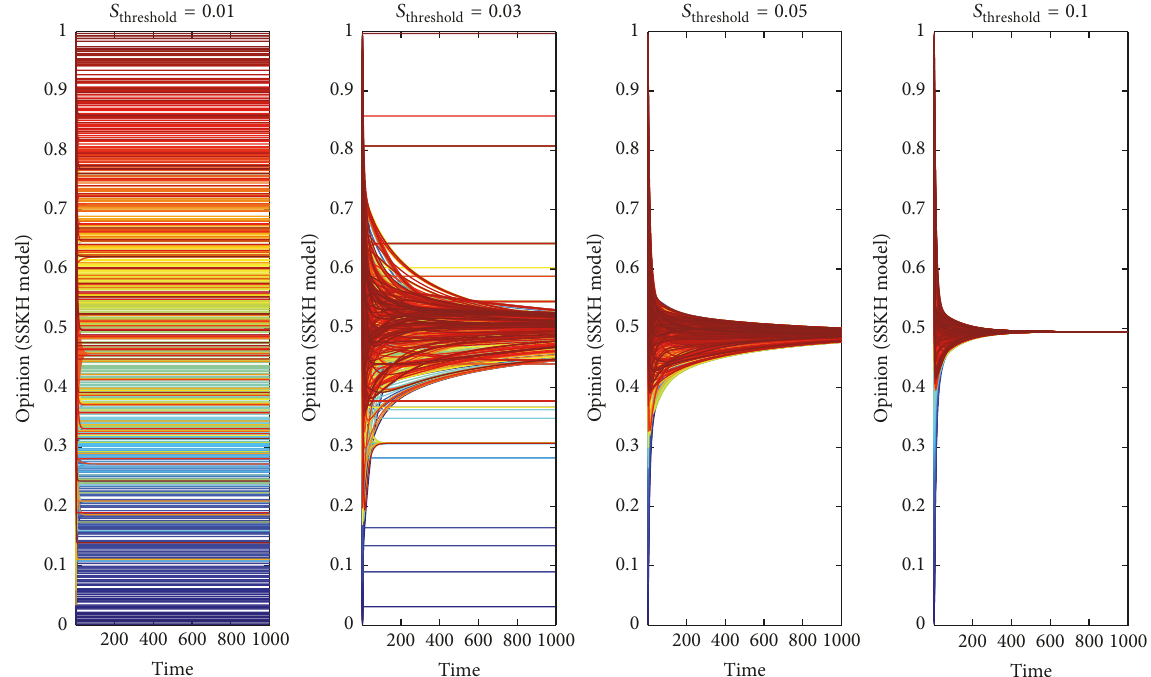
Figure 1: Opinion evolution results of the SSHK model by changing the social similarity with different 𝑠